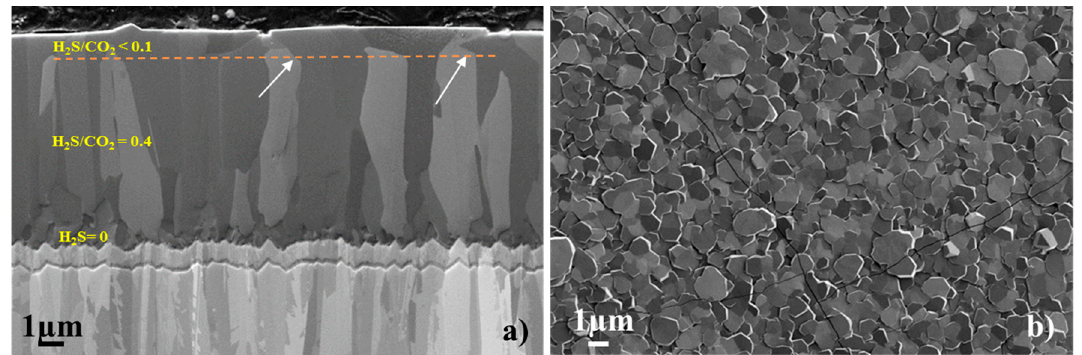
Figure 9. ( a ) Cross-section SEM micrograph of α -Al 2 O 3 coating (Coating h) deposited at H 2 S / CO 2 = 0.4 for 420 min and at H 2 S / CO 2 < 0.01 for 60 min. An abrupt change in the growth direction (arrowed) occurred. ( b ) Surface morphology showing the coating surface being terminated by flat surfaces.